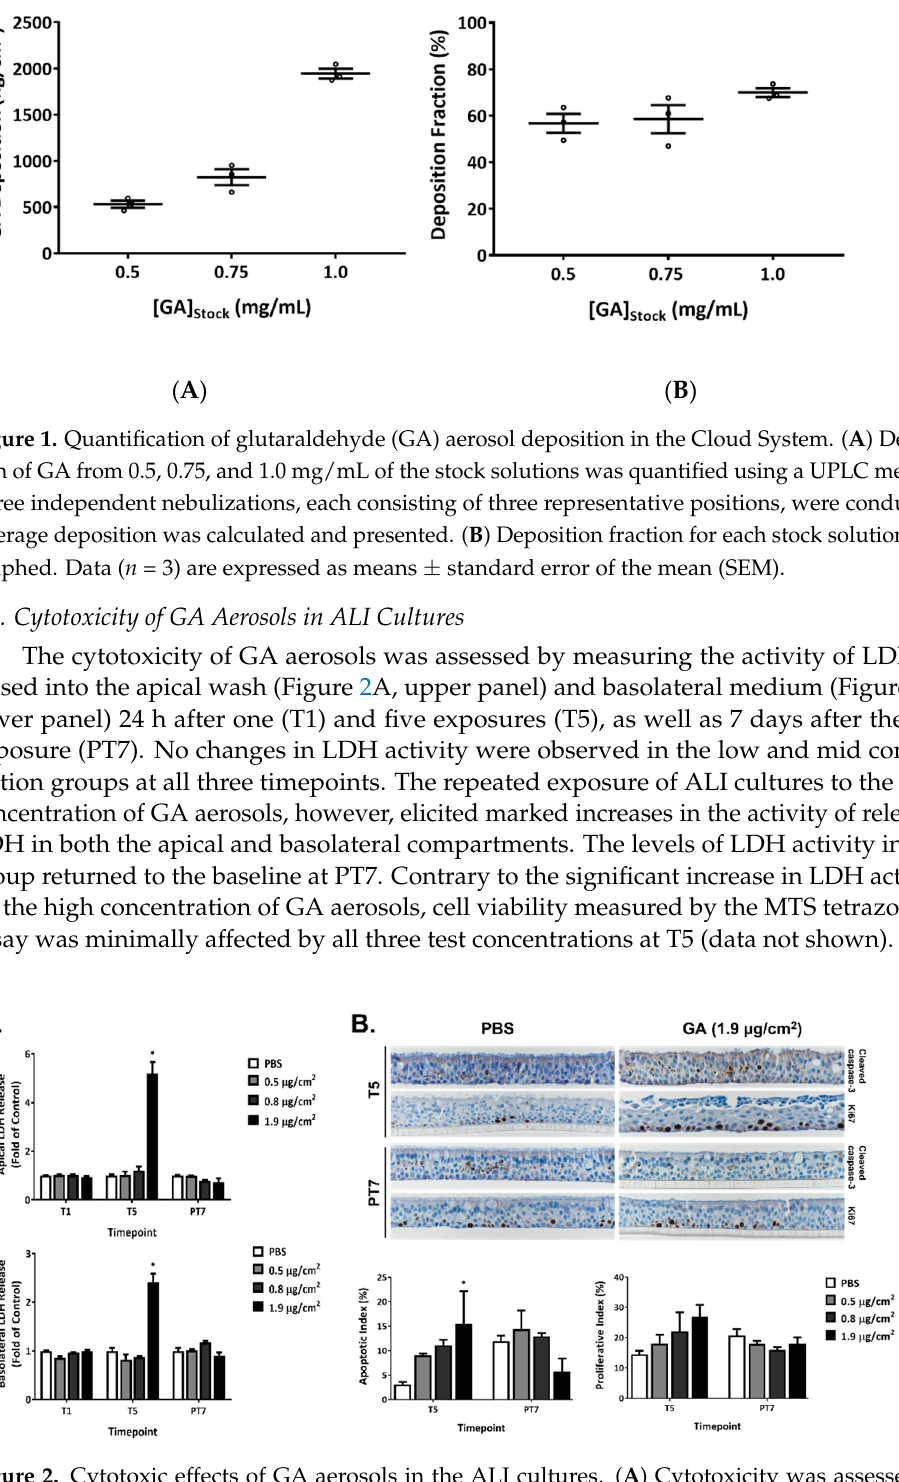
Figure 2. Cytotoxic effects of GA aerosols in the ALI cultures. ( A ) Cytotoxicity was assessed by measuring the LDH activity in both the apical washes and basolateral media at T1, T5, and PT7. ( B ) Apoptotic and proliferative effects of GA aerosols were evaluated by IHC with cleaved caspase-3 and Ki67 antibodies at T5 and PT7, respectively. Representative images (upper panel) were captured at 40 × magnification. Apoptotic and proliferative indices were calculated and are presented in the bottom panel. Data ( n = 3) are presented as means ± SEM. * p < 0.05 was considered statistically significant compared to the PBS-exposed vehicle